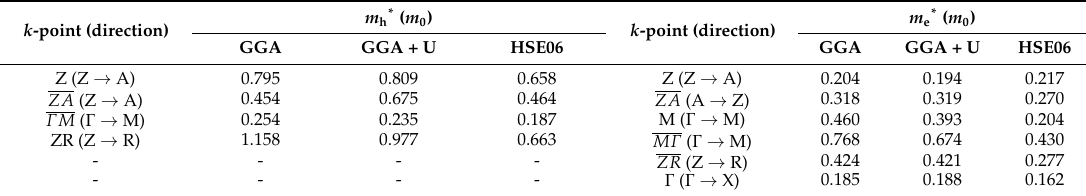
Table 3. Effective masses of photogenerated holes at the top of the VB (valence band) and photogenerated electrons at the bottom of the CB (conduction band) obtained by different DFT methods.